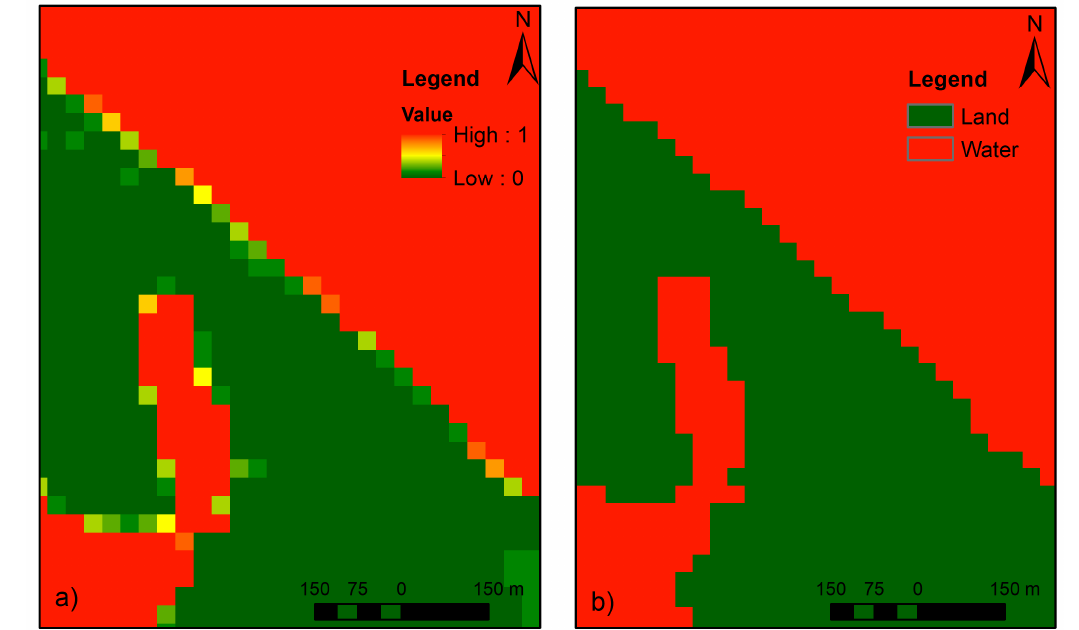
( b ) Figure 6. ( a ) An example of the mNDWI map and ( b ) land–water classification map of Quang Nam province on 4 July, 2019.